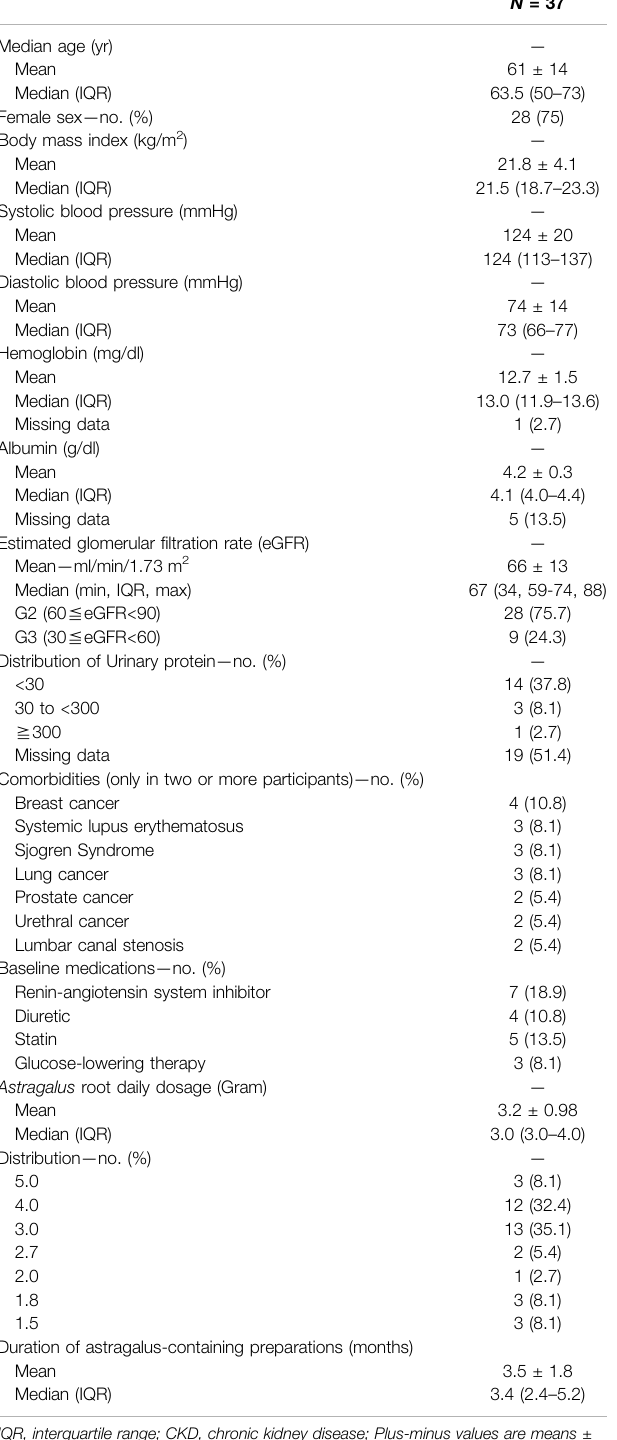
TABLE 1 | Background of participants.